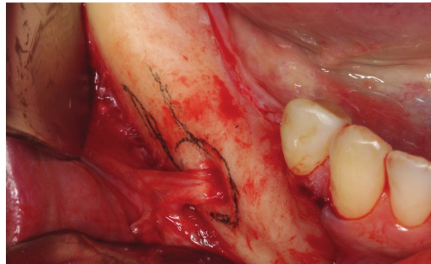
Figure 6: Mental foramen displacement.